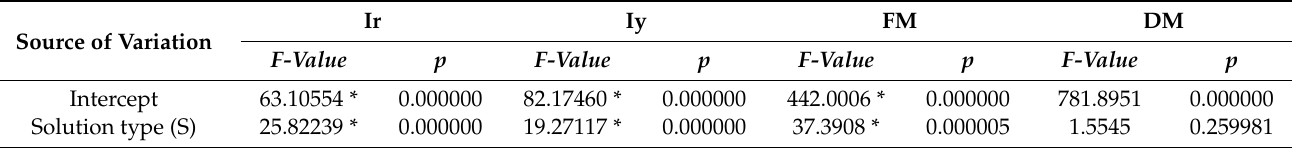
Table 3. Analysis of variance (ANOVA) for morphological features of L. minor exposed to